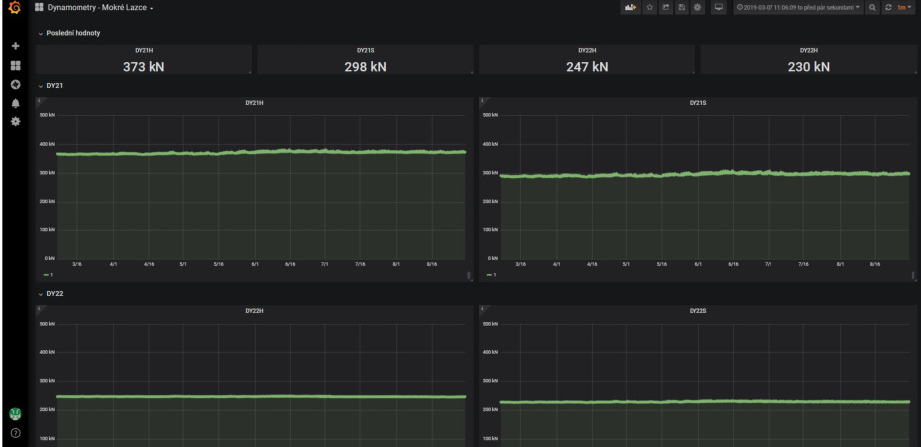
Figure 7. The Grafana system shows the loads on the gabion